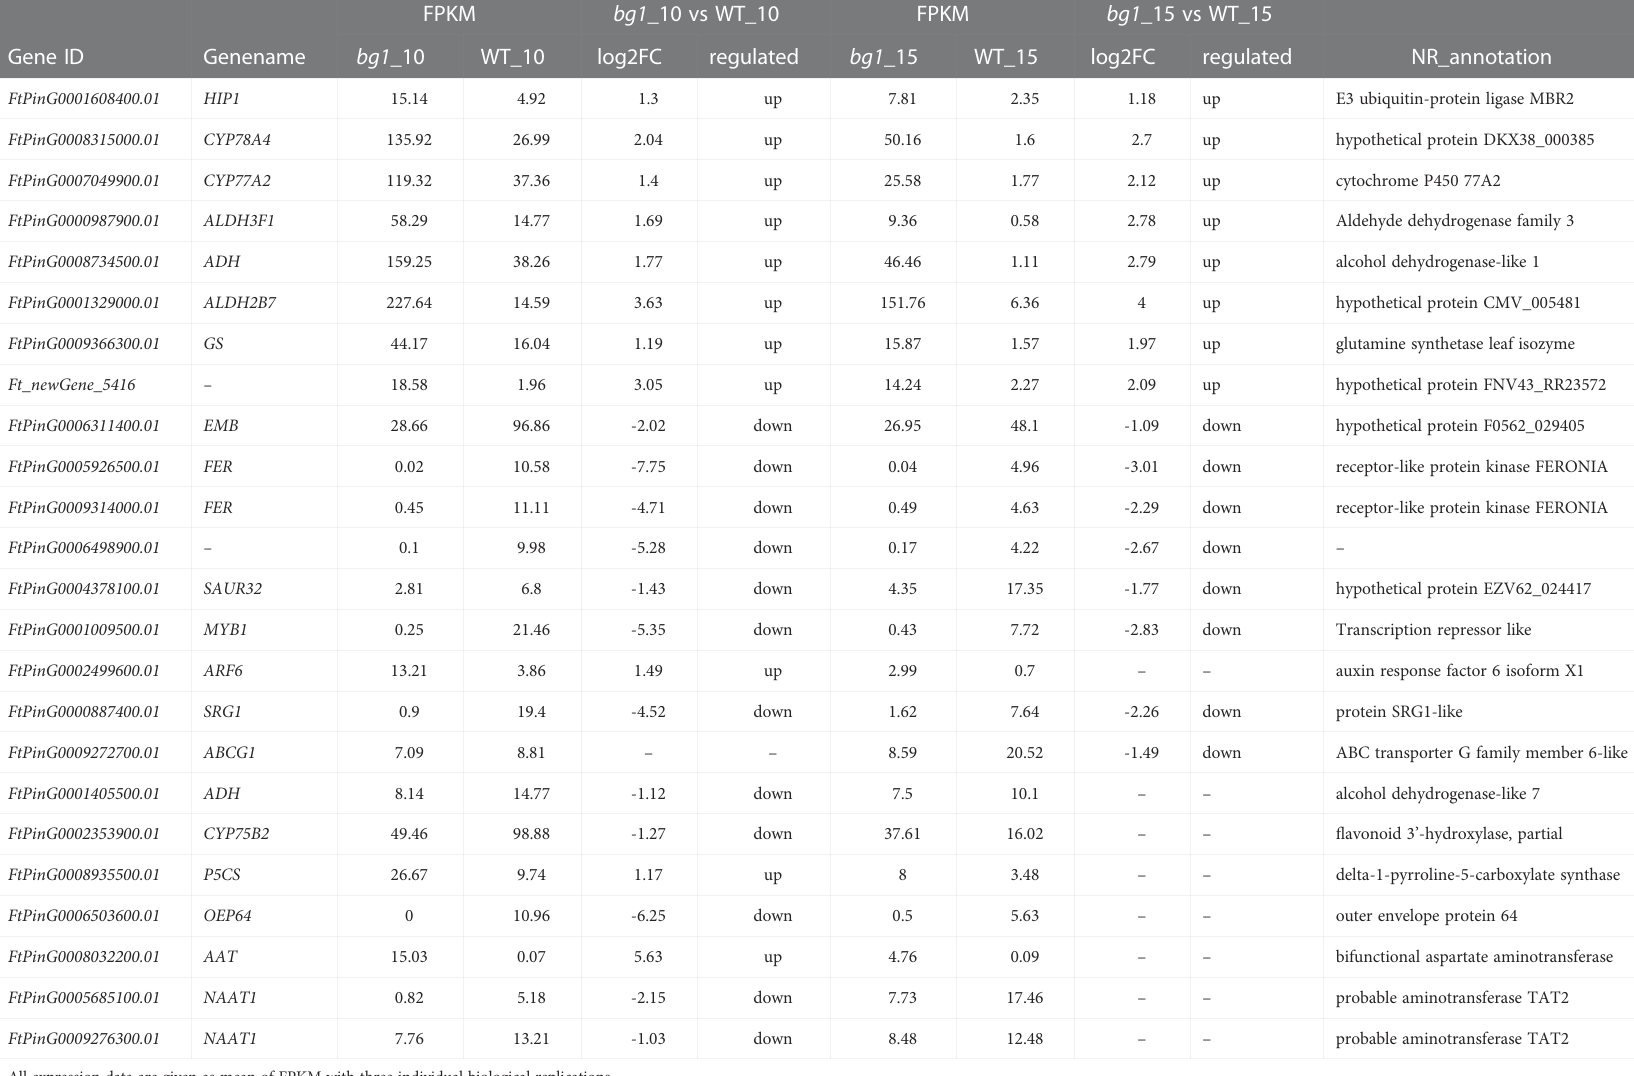
All expression data are given as mean of FPKM with three individual biological